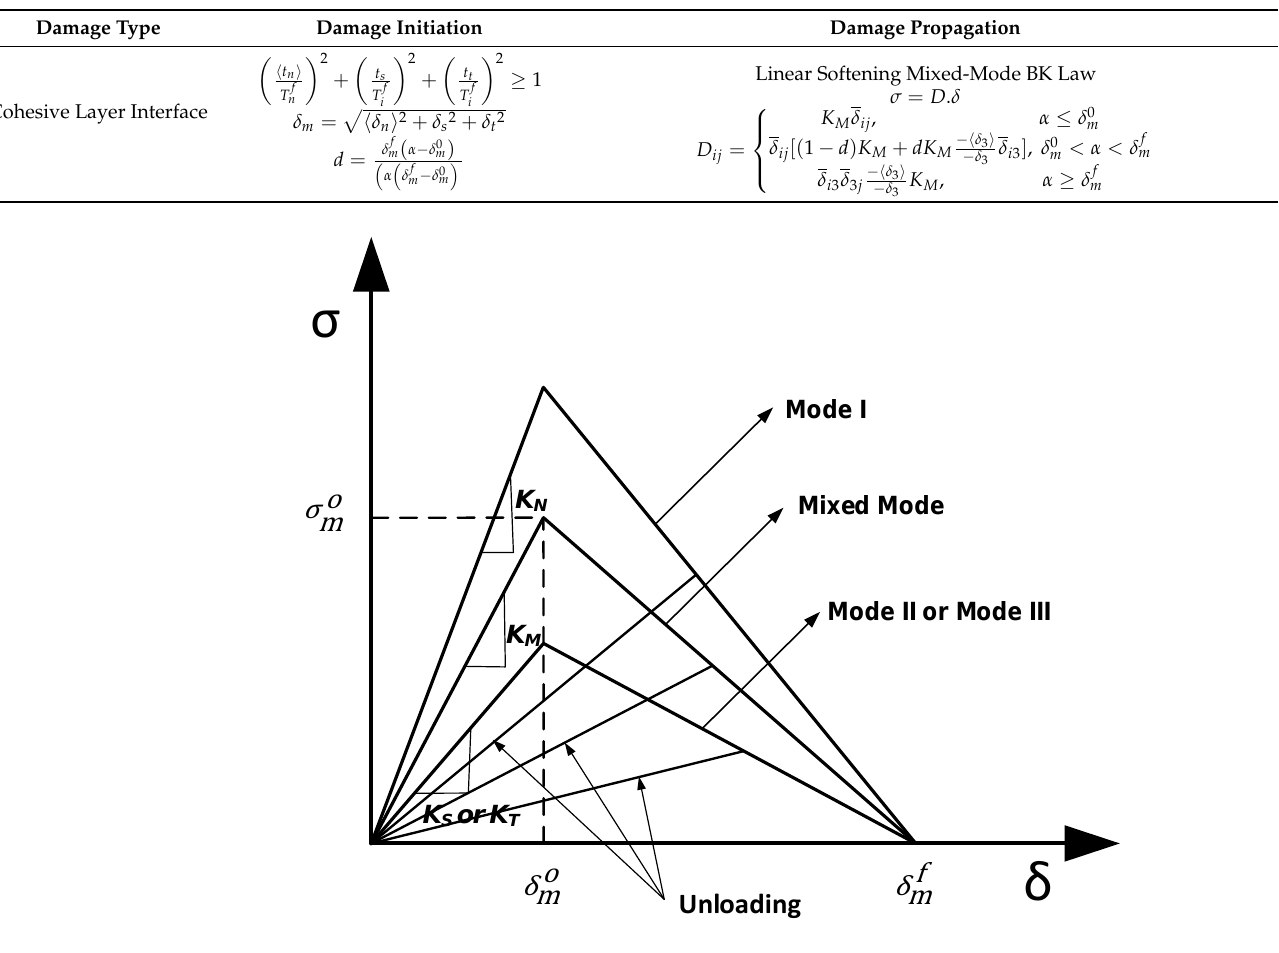
Figure 3. Schematic diagram of cohesive interface linear softening model [31,32]. Material properties of cohesive interface are given in Table 4. Table 4. Material properties of cohesive interface between plies.